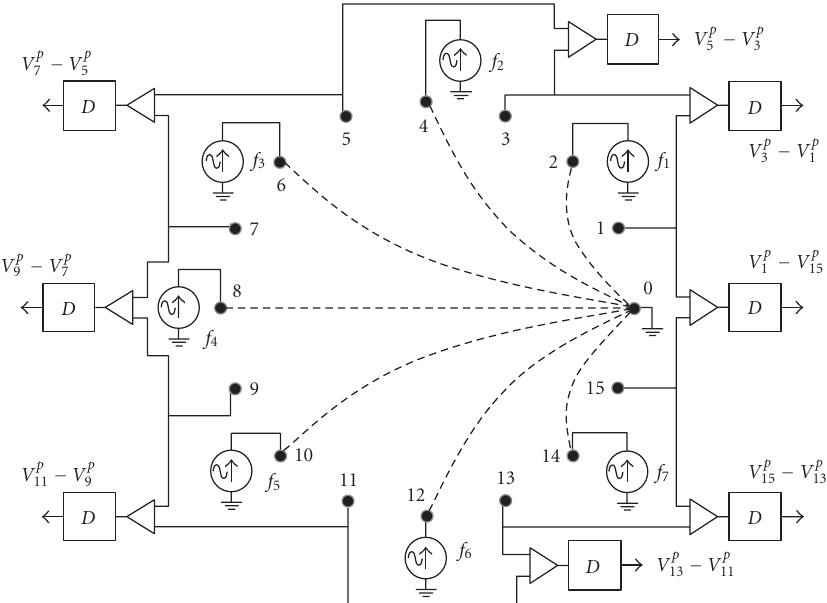
Figure 2: Implementation of a possible FDM EIT system with 16 electrodes. AC currents at di ff erent frequencies are injected simultaneously into the sample and are collected by a single electrode (0). Di ff erential voltage at electrode pairs are amplified and processed by demodulators (D).